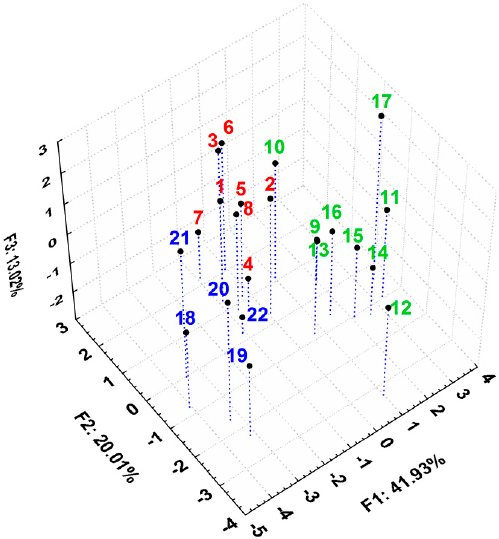
Figure 10. 3D scatterplot of the scores for the first three principal components after applying PCA on all the discussed parameters describing biological activity and lipophilicity for all studied compounds.